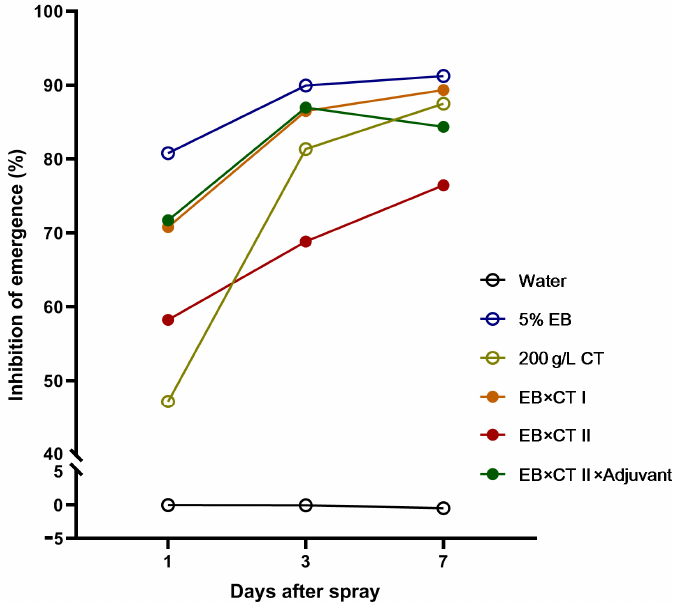
Figure 1. Efficacies of the emamectin benzoate × chlorantraniliprole mixture with and without ad- juvant Jijian ® against S. frugiperda in a field trial. Efficacies were assessed by the mean of the inhibi- tion of emergence (EI, %) of insect populations sampled in four trial plots. EB, emamectin benzoate; CT, chlorantraniliprole. Water, 450 L/ha.; 5% EB, 5% emamectin benzoate WDG, 15 g/ha.; 200 g/L CT, 200 g/L chlorantraniliprole SC, 150 mL/ha.; EB × CT I, routine dose of EB × CT mixture at 9:1, 5% EB, 13.5 g/ha., and 200 g/L CT, 0.375 mL/ha.; EB × CT II, reduced dose of EB × CT mixture at 9:1, 5% EB, 2.7 g/ha., and 200 g/L CT, 0.075 mL/ha.; EB × CT II × adjuvant, reduced dose of EB × CT mixture at 9:1 supplemented with adjuvant, 5% EB 2.7 g/ha., 200 g/L CT 0.075 mL/ha. and Adjuvant Jijian ® 450 mL/ha.